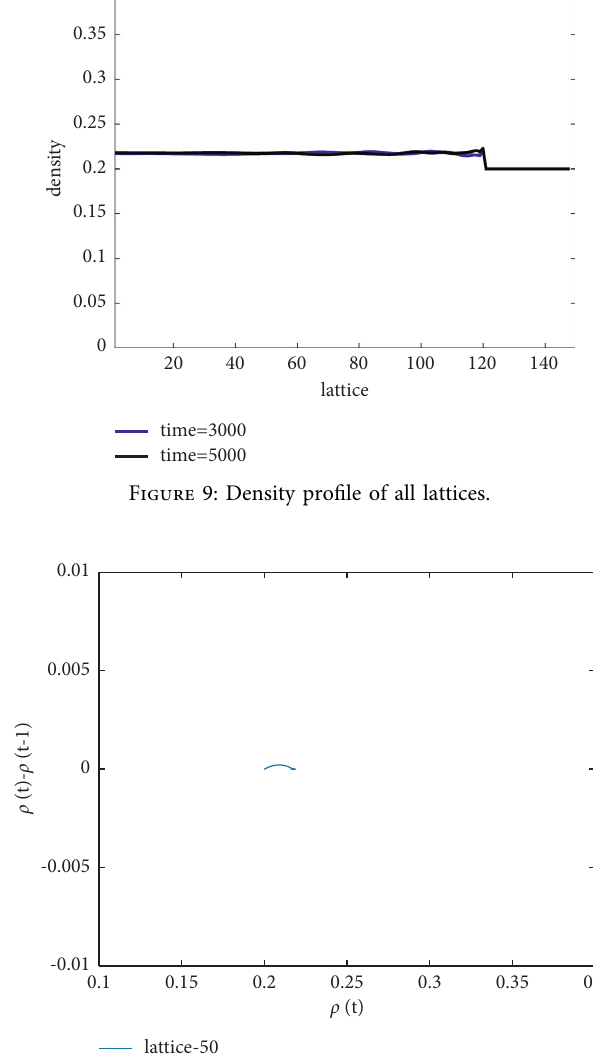
Figure 10: Phase